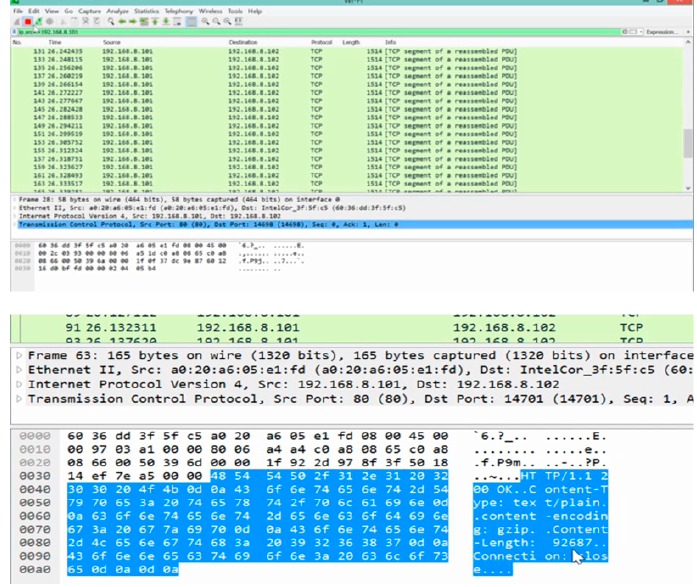
Figure 8. The packet captured during transmission between ESP8266 and Arduino.